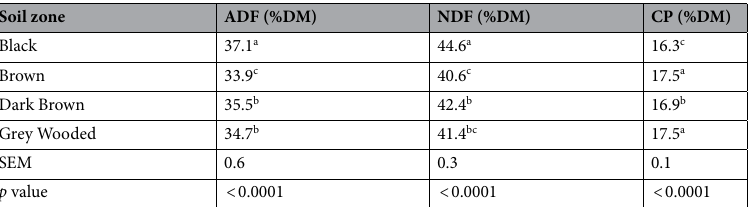
Table 4. Mean comparison of three nutritive value traits among four soil zones for 14 alfalfa populations with long-term grazing history from 2018 to 2019 at the Agriculture and Agri-Food Canada Saskatoon Research Farm, SK, Canada. Note: ADF, acid detergent fiber; NDF, neutral detergent fiber; CP, crude protein. The different lowercase letters within a column are significantly different according to Tukey’s HSD at p ≤ 0.05. SEM, standard error of the